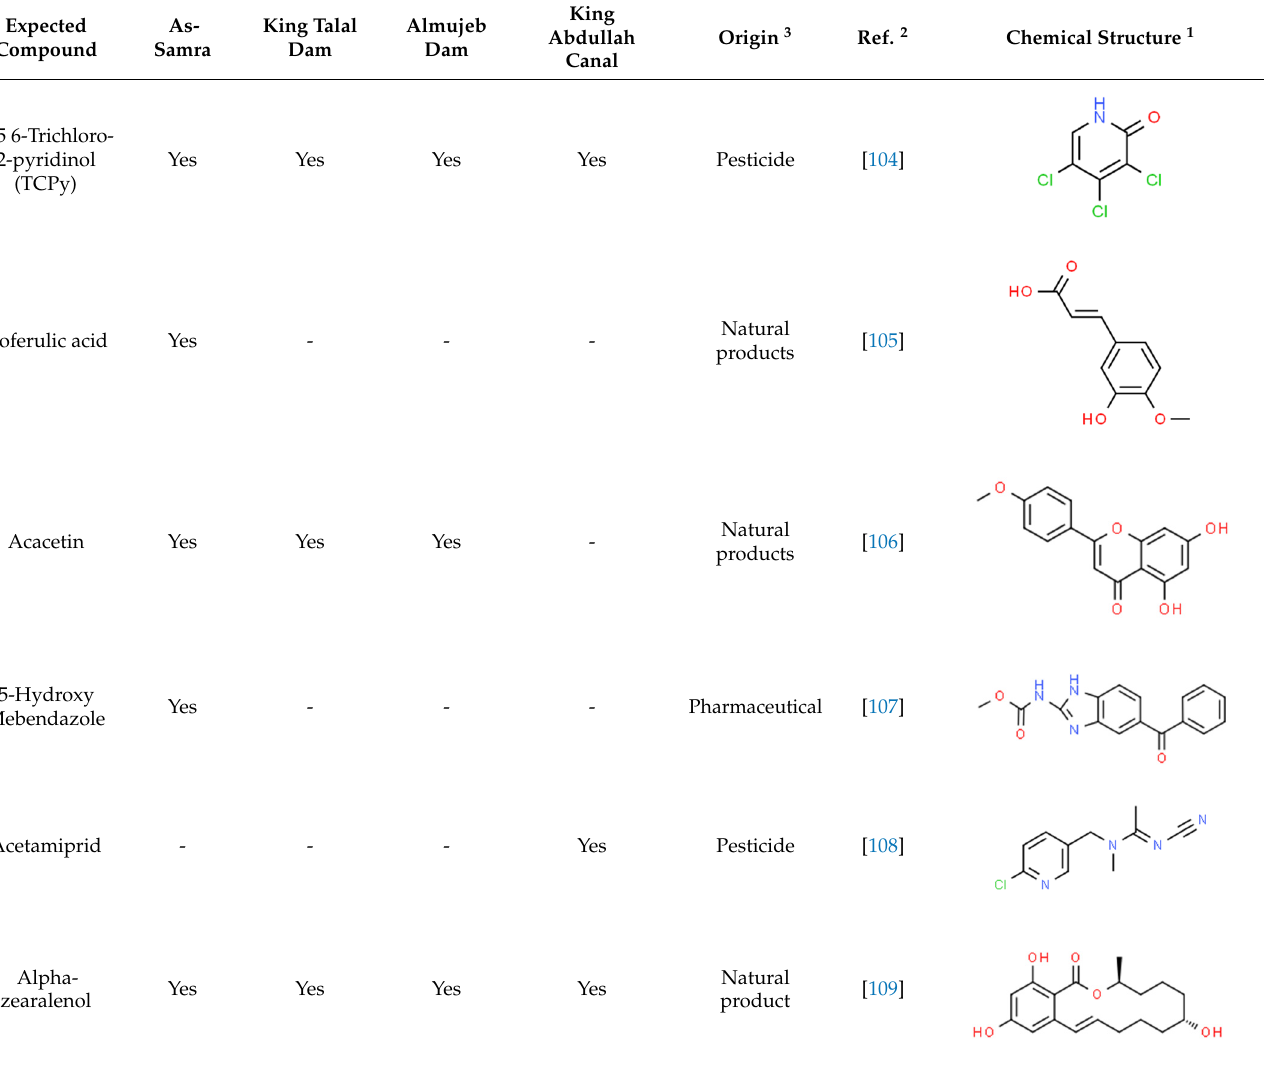
Table 4. Detected xenoestrogens in open surface water.